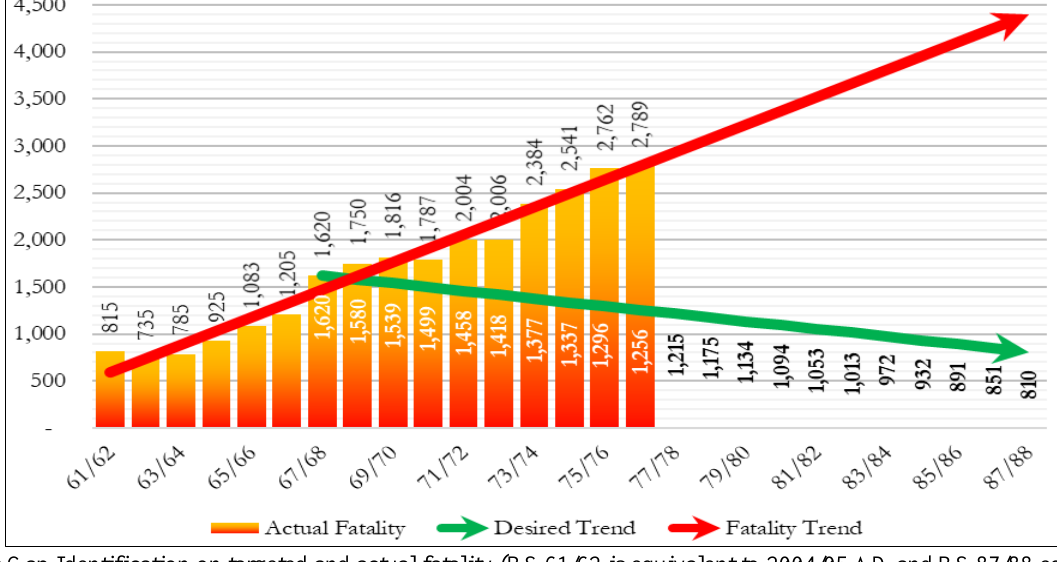
2030/31AD). Source: [5].